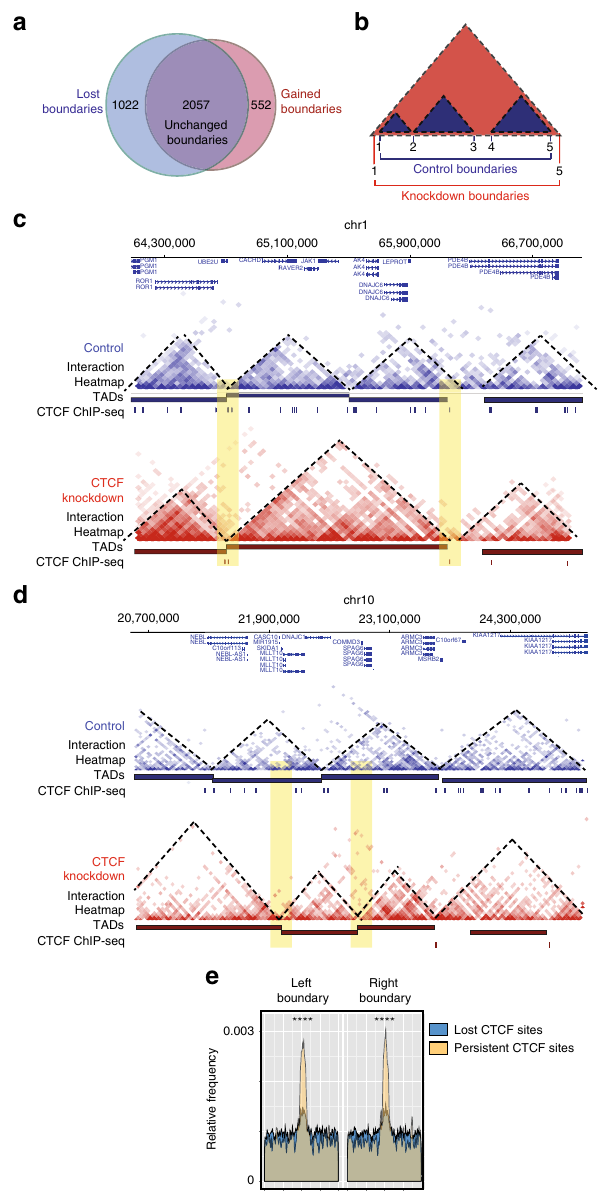
Fig. 6 TAD boundaries are altered after CTCF RNAi in LNCaP cells. a Venn diagram demonstrates number of shared, lost and gained TAD boundaries between control and CTCF knockdown conditions. b Schematic illustrating TAD merging and loss/retention of TAD boundaries. c Screenshot from Washu epigenome browser showing chromatin interaction heatmaps, TADs and CTCF ChIP-seq data for 144 h control (blue) and CTCF (red) RNAi conditions in LNCaP cells. At this locus, two TADs become merged into one upon loss of CTCF binding across the region. The larger, merged TAD has persistent CTCF binding at its maintained boundaries. d Screenshot from Washu epigenome browser showing chromatin interaction heatmaps, TADs and CTCF ChIP-seq data for 144 h control (blue) and CTCF (red) RNAi conditions in LNCaP cells. At this loci new TAD boundaries are formed upon loss of CTCF binding across the region (highlighted in yellow). e Positional enrichment of all lost and all persistent site binding at topological domain boundaries following CTCF RNAi demonstrates that persistent CTCF sites are enriched at domain boundaries that are present following knockdown (two-tailed t -test, p < 0.0001; n = 2 biologically independent